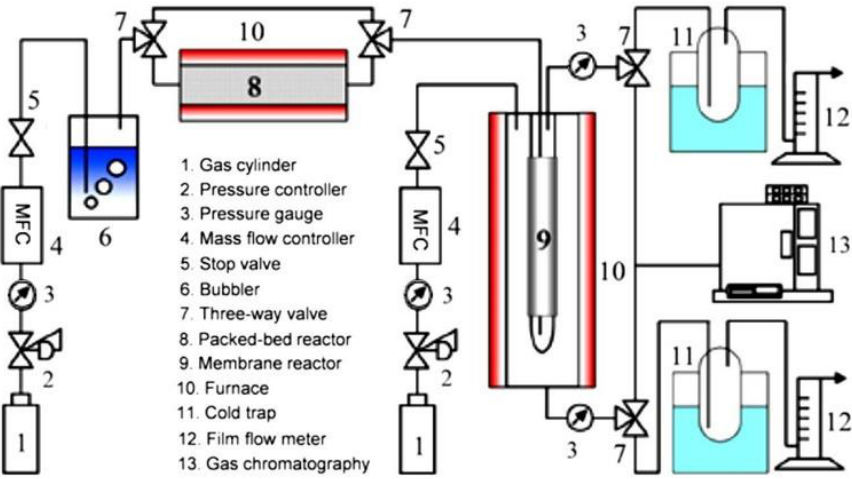
Figure 5. Schematic diagram of ex-situ catalytic membrane reactor system with individual numbered components shown in the included list. Adapted from [33] with permission.